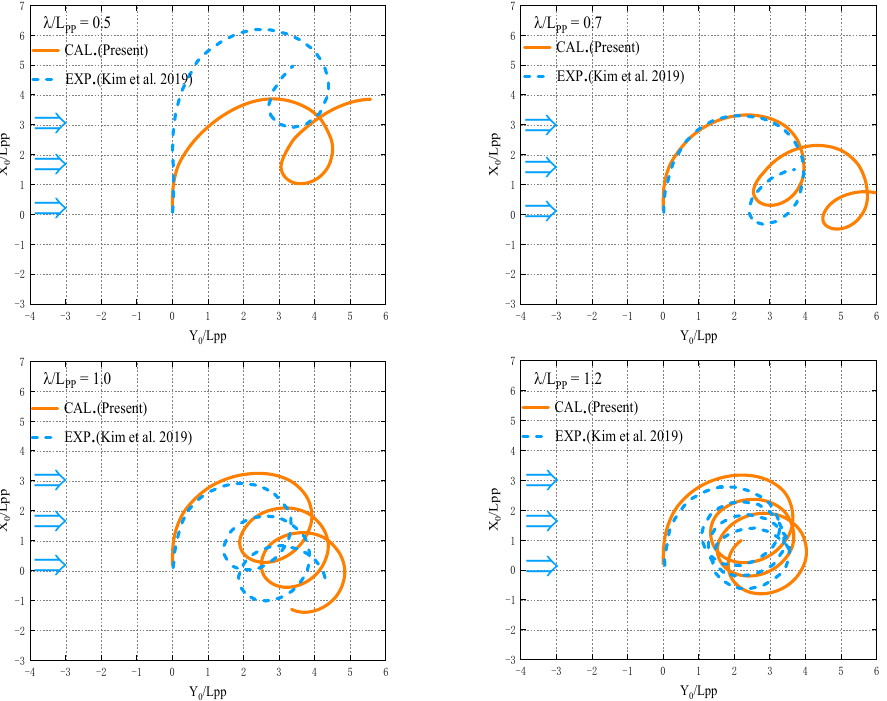
Figure 25. Comparisons of the turning trajectory of +35° turns with the wavelength variation in the beam waves. The experimental values were reproduced from [8], with permission from Elsevier, 2022.